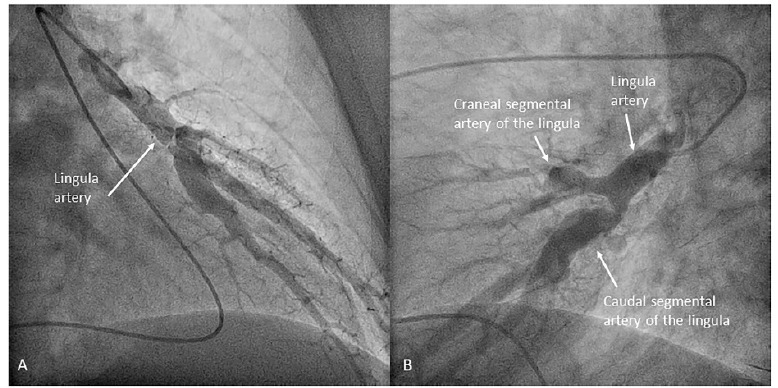
Figure 11. Lingula artery and segmental branches: cranial (A4) and caudal (A5): ( A ) anteroposterior view and ( B ) lateral